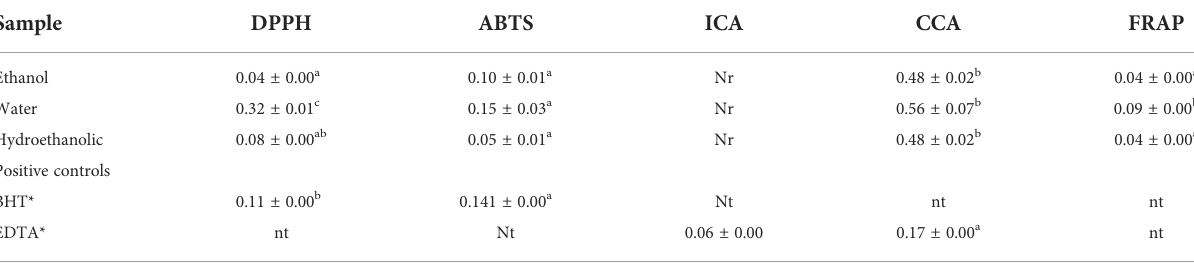
TABLE 4 Radical scavenging activity (RSA) on DPPH and ABTS, metal chelating activity on copper (CCA) and iron (ICA) and ferric reducing activity power (FRAP) of different extracts of Limonium spathulatum .